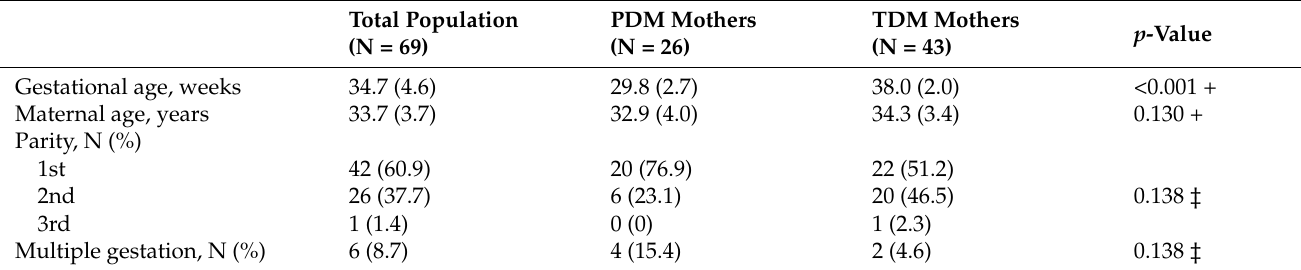
Table 2. Characteristics of donor